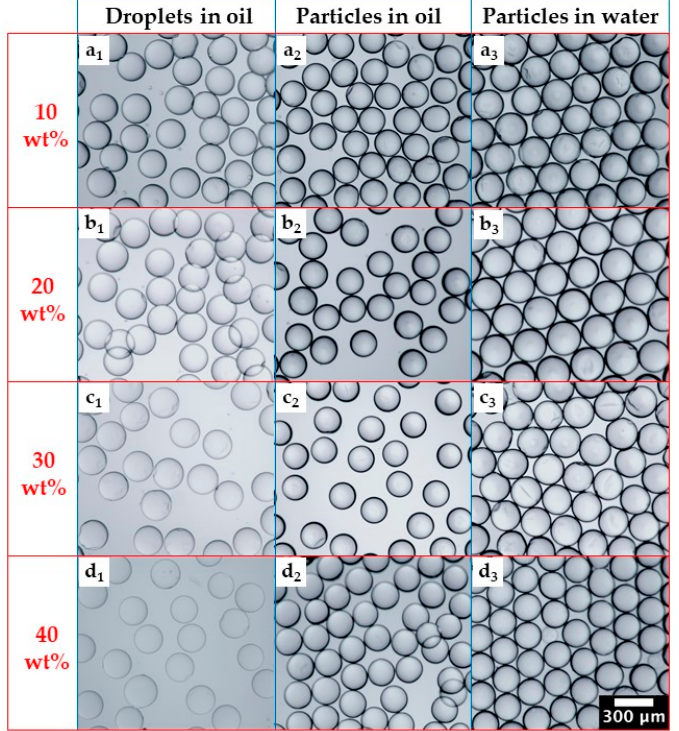
Figure 8. Optical microscopy images of droplets and PEGDA particles prepared using different water contents in the dispersed phase: ( a ) 10 wt%; ( b ) 20 wt%; ( c ) 30 wt%; ( d ) 40 wt%. Subscripts 1, 2, and 3 refer to collected emulsions before photopolymerization, PEGDA particles in silicone oil after photopolymerization, and PEGDA particles in DI water after washing with acetone. The same scale bar applies to all figures.